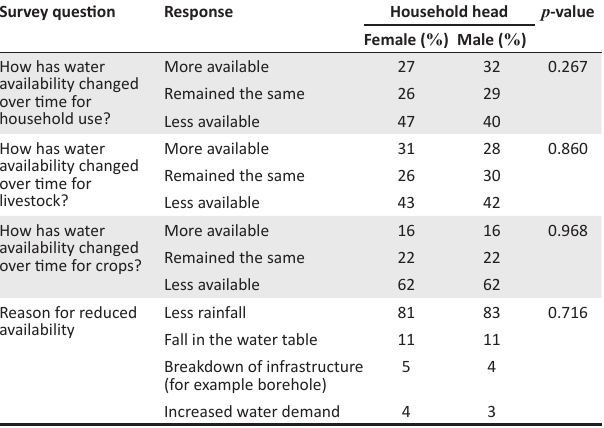
TABLE 3: Perceptions of changes in water availability.